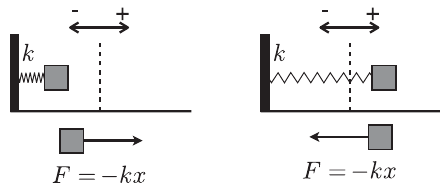
FIG. 4. Spring forces on a moving